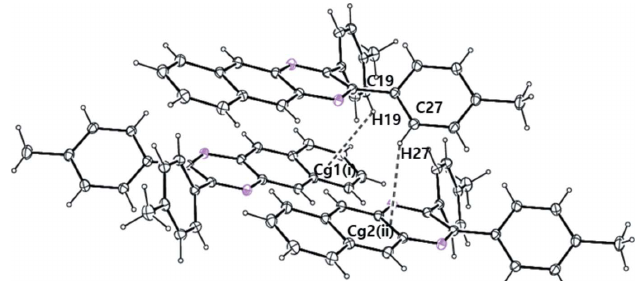
Figure 2 Part of the crystal packing showing molecules linked by intermolecular C—H (cid:2)(cid:2)(cid:2) (cid:2) interactions (Table 1; shown as dashed lines). Cg 1 and Cg 2 are the centroids of the C7–C12 and the N1/C2/C3/N4/C5–C7/C12–C14 rings, respectively. [Symmetry codes: (i) (cid:5) x + 1, (cid:5) y , (cid:5) z , (ii) x (cid:5) 1, y , z ].